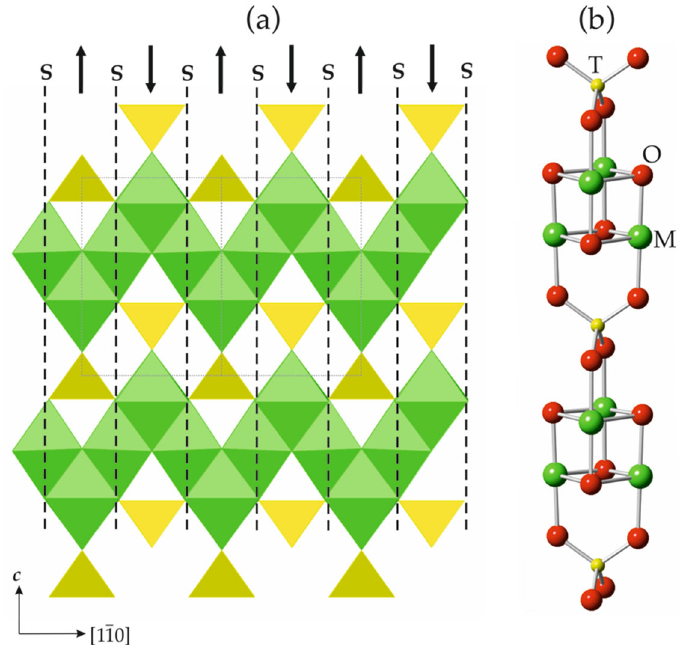
Figure 8. The crystal structure of spinel projected along [110] ( a ) and the ball-and-stick representation of a spinel module ( b ). The dashed lines outline the contours of the modules, whereas the arrows indicate their orientation. The T- and M-centered polyhedra in ( a ) are shown in yellow and green, respectively.